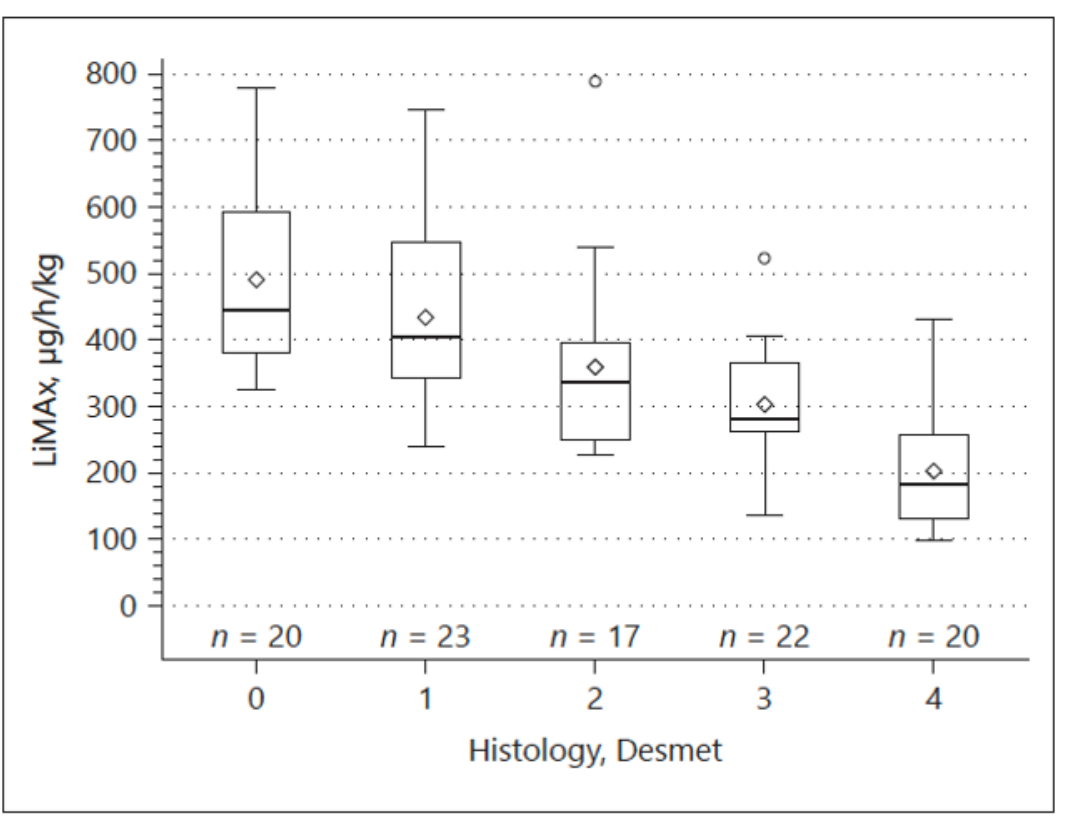
Figure 2. Correlation between LiMAx and histological specimen classified according to the Desmet scoring system.